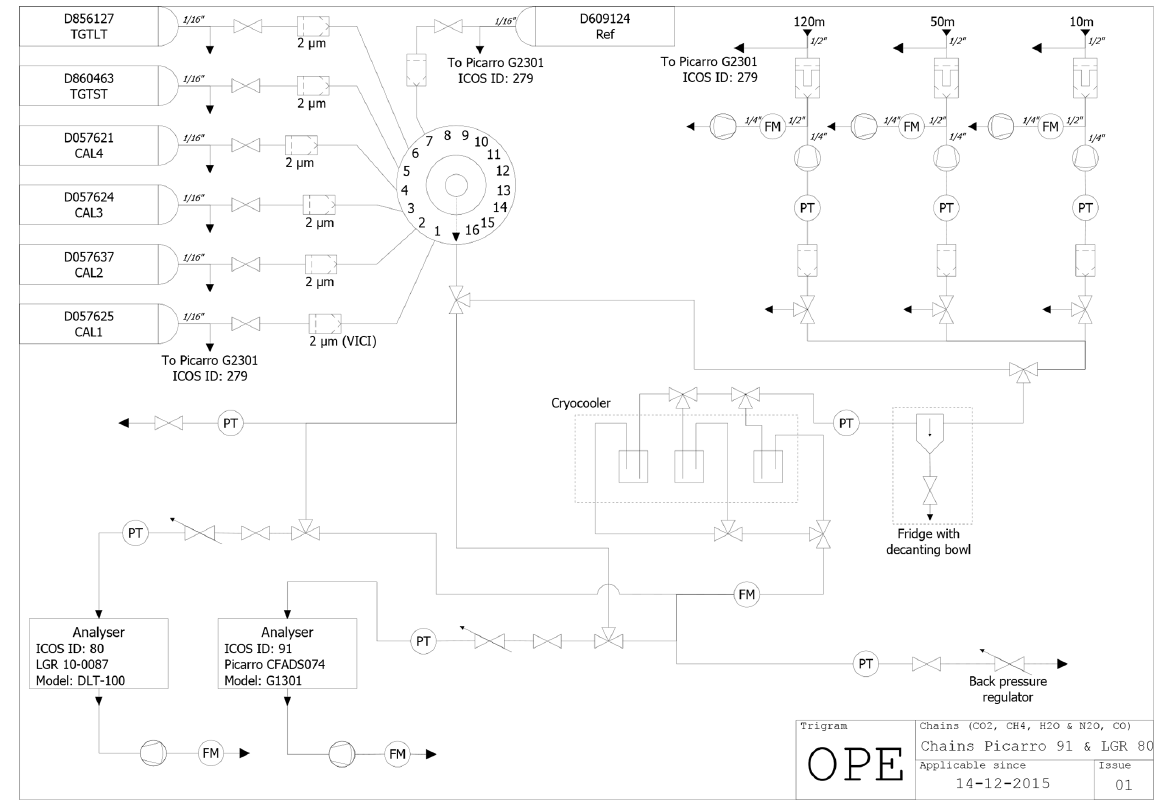
Figure 3. Flow diagram of the OPE GHG measurement system (FM: flowmeter; PT: pressure transducer).